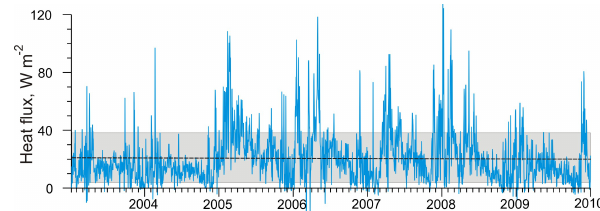
Figure 10. Time series (2003–2010) of daily mean simulated verti- cal heat fluxes (Wm − 2 ) across the upper SFSBW interface at 75m averaged over the ST eastern slope (the area depicted by the yel- low dashed rectangle in Fig. 9). The black dashed line indicates the 2003–2010 mean (20.5Wm − 2 ) and the gray shading shows ± 1 standard deviation from the